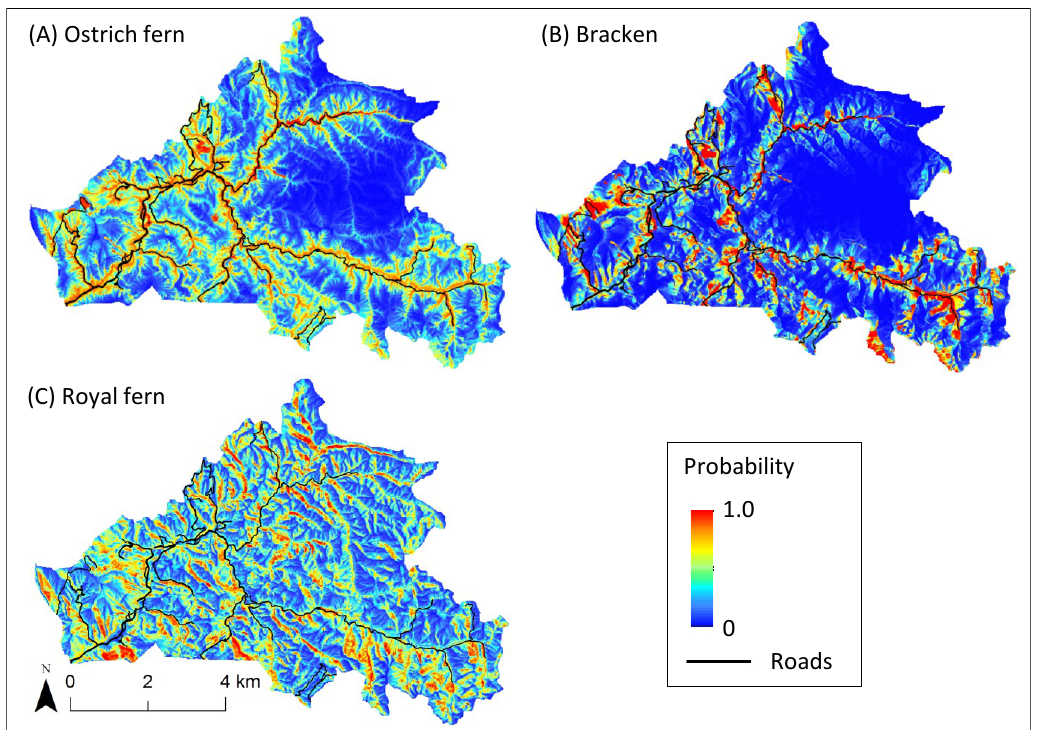
Figure 3. Estimated potential harvesting sites of three edible wild ferns ( i.e. , A , Ostrich fern; B , Bracken; C , Royal fern) based on the results of generalized liner models